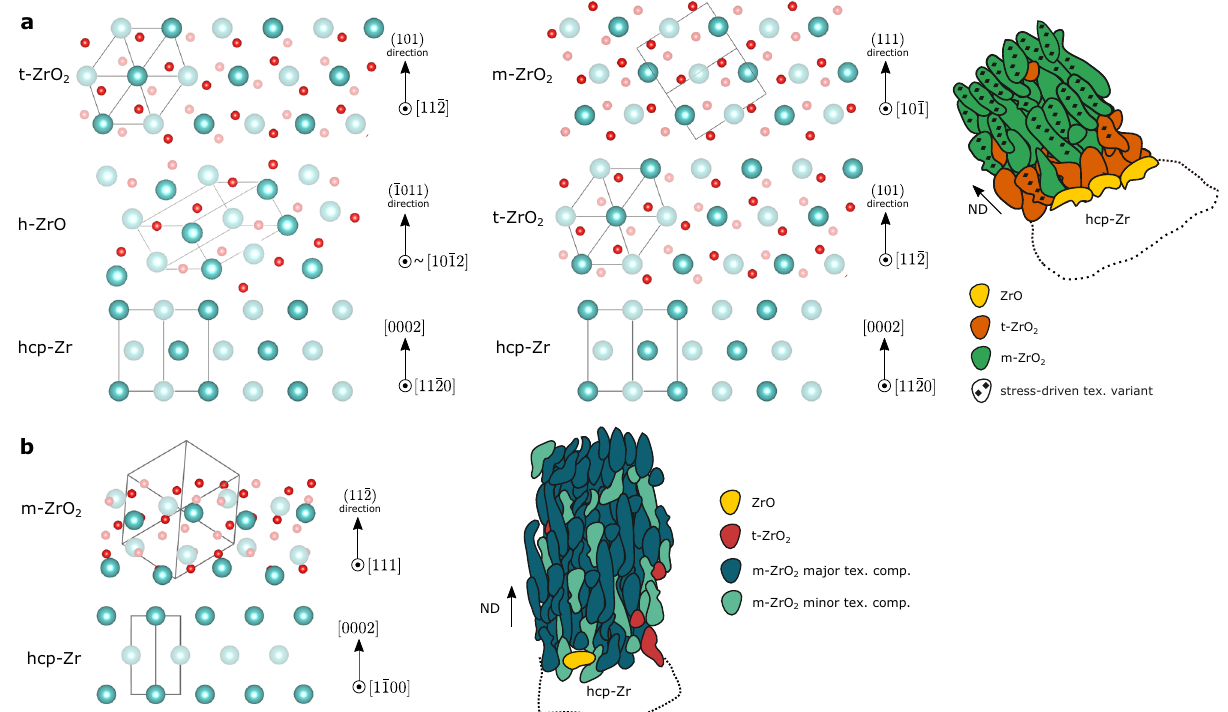
relative distance and darker atoms are closer to the reader. Blue and red spheres ∣∣ f (cid:1) 1011 g represent Zr and O atoms, respectively. Produced using VESTA 69 . Schematics of 2 ∣∣ f 101 g <11 (cid:1) 2> ∣∣ f 0002 g the oxide microstructure show the normal direction and how it relates to the t (cid:2) ZrO 2 2 ∣∣ f 0002 g <1 (cid:1) 100> crystal directions for reference. Zr . Two atomic 2